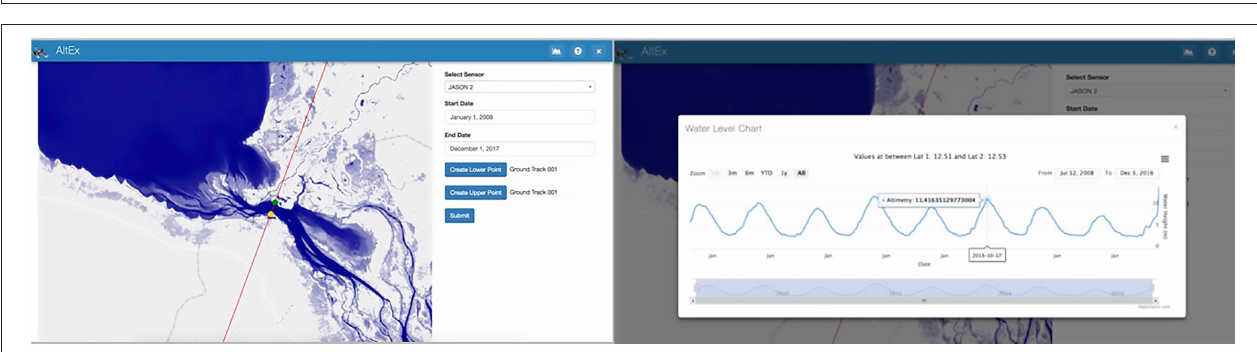
FIGURE 15 | AltEx web application user interface over Tonle Sap, Cambodia (Left) and water level chart as rendered in AltEx web application (Right) . Figure taken from Markert et al. (2019).